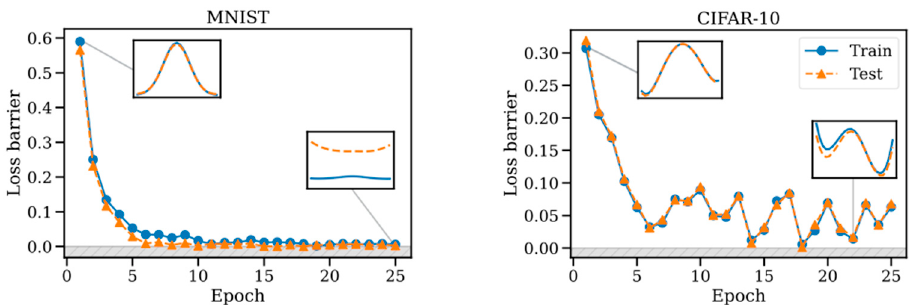
Figure 2. Loss barriers as a function of training time for MLPs trained on MNIST ( left ) and CIFAR-10 ( right ). Linear mode connectivity challenges reduce after initialization. Loss interpolation plots are inlaid to highlight results in initial and later epochs (the y-axis scales differ). From Git Re-Basin: Merging Models modulo Permutation Symmetries [99].